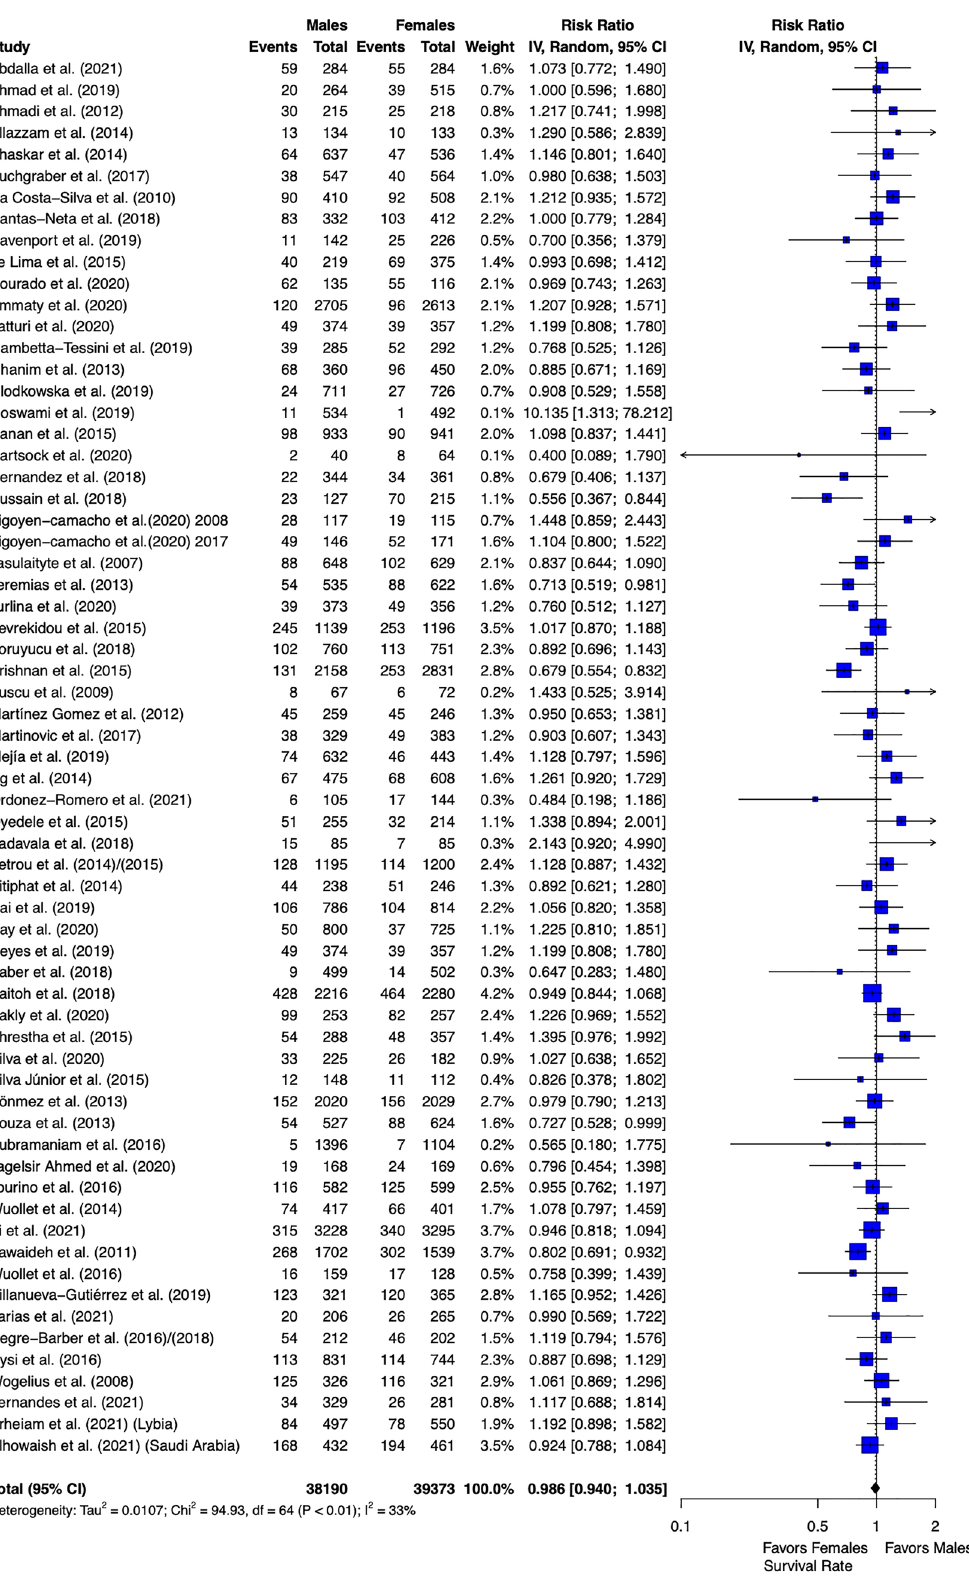
Figure 2. Forest plot of meta-analysis comparing MIH prevalence of female versus male